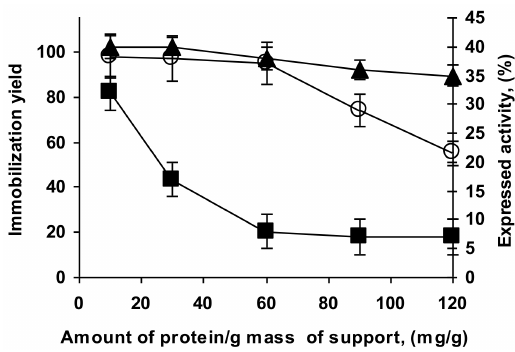
Figure 11. Immobilization yield and expressed activity when growing the amount of offered ficin extract per g of MANAE activate with glutaraldehyde support. Experiments were carried out as described in Methods section. Triangles: immobilization yield; Circles: expressed activity versus BANA, Squares: expressed activity versus